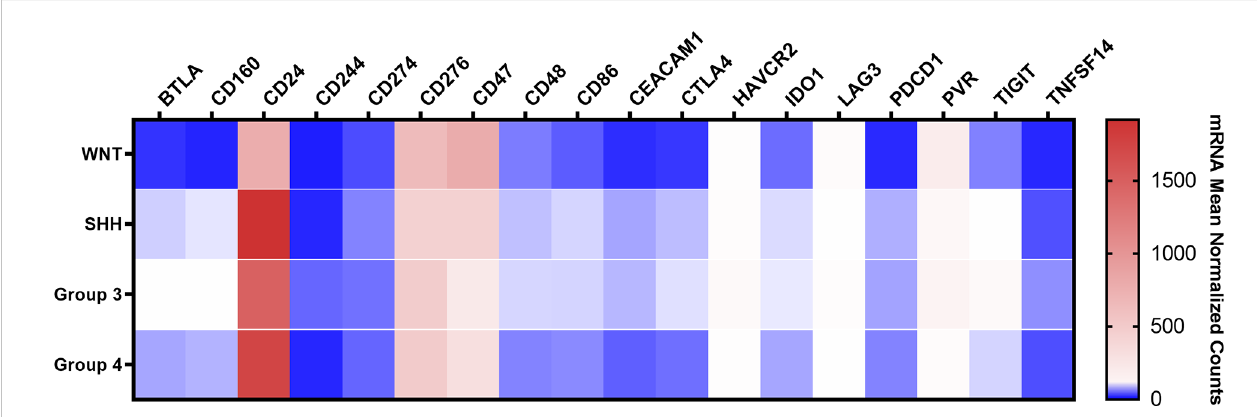
FIGURE 1 Heatmap of the mRNA levels of 19 immune checkpoint-related genes in the Brazilian 80 medulloblastomas. The color scale represents the mean normalized mRNA counts of the evaluated genes. Blue represents counts below the background threshold; white represents low counts (below 100 counts); red represents higher counts. The graph was obtained through GraphPad Prism 8.